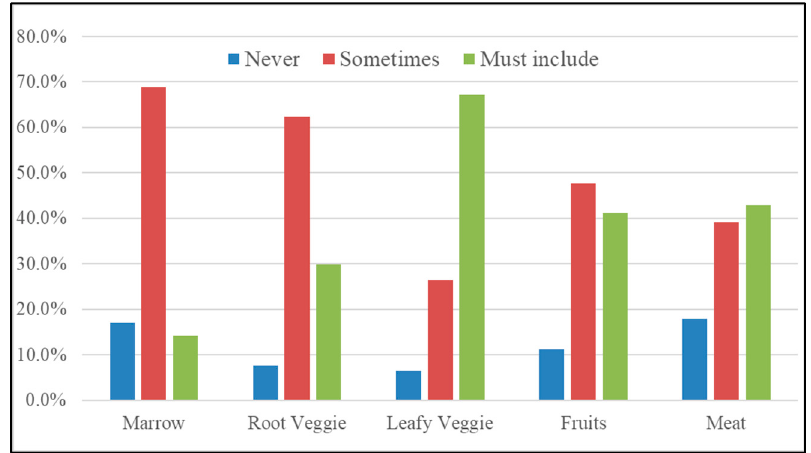
Figure 4. Consumers’ preferences for ingredients included in their fresh food boxes. Note: FFB means a fresh food box. Source: Authors’ calculation.